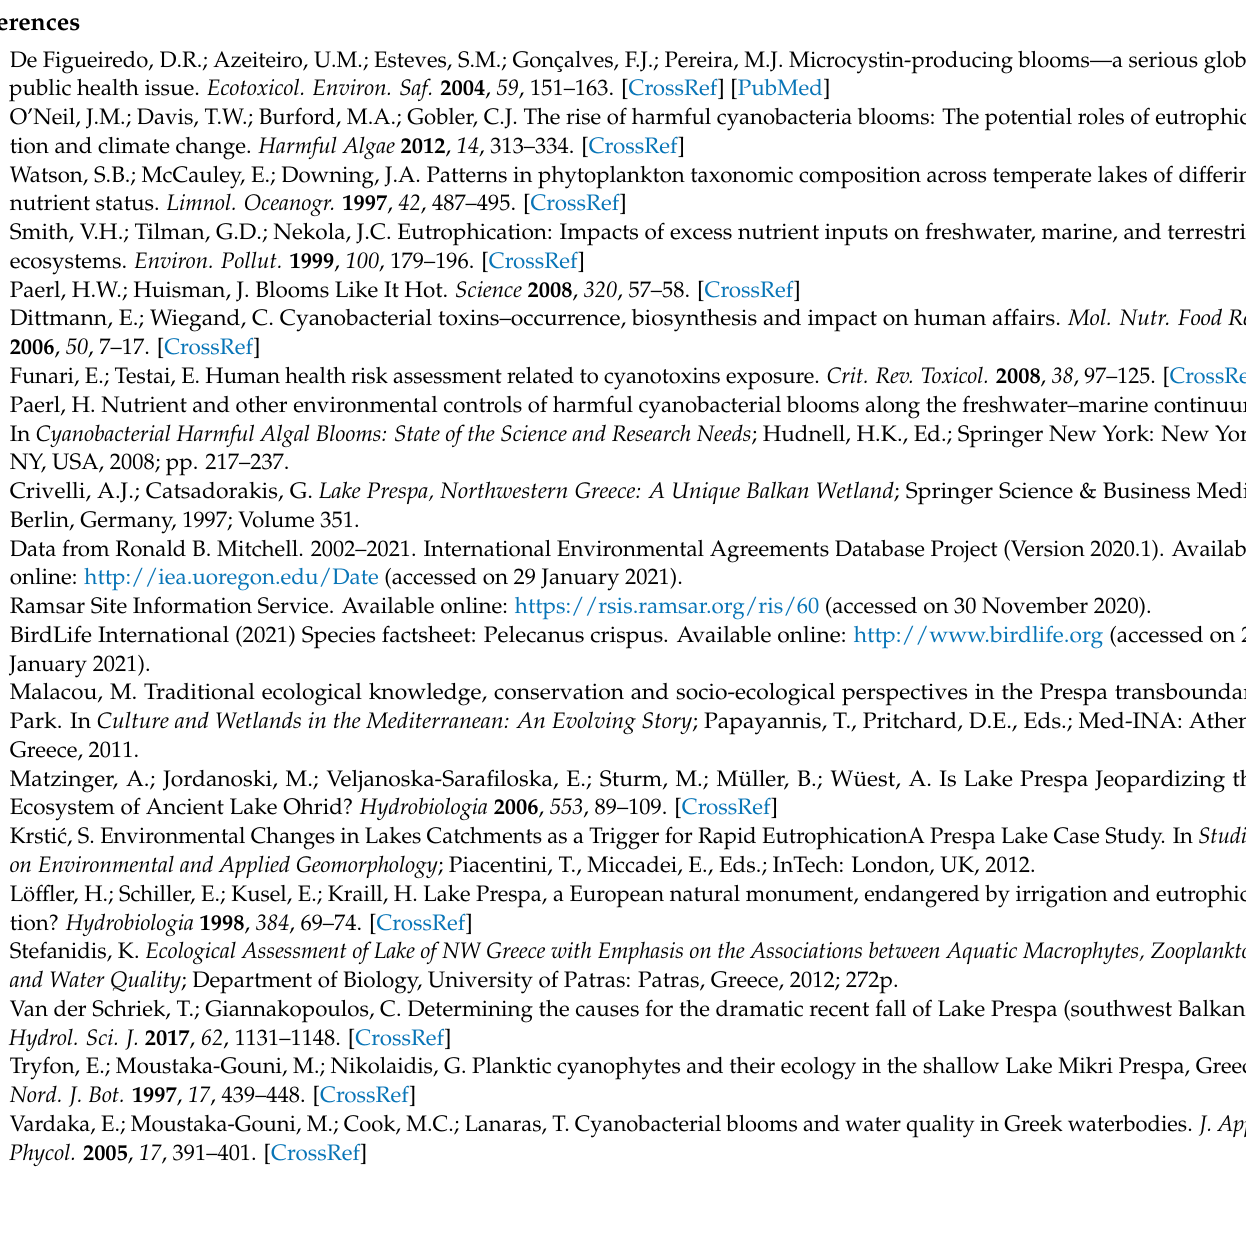
Figure A2. Photo of Vromolimni pond water showing the excessive cyanobacteria growth during sampling on 26 September 2012 (photo provided by the Society for the Protection of Prespa).